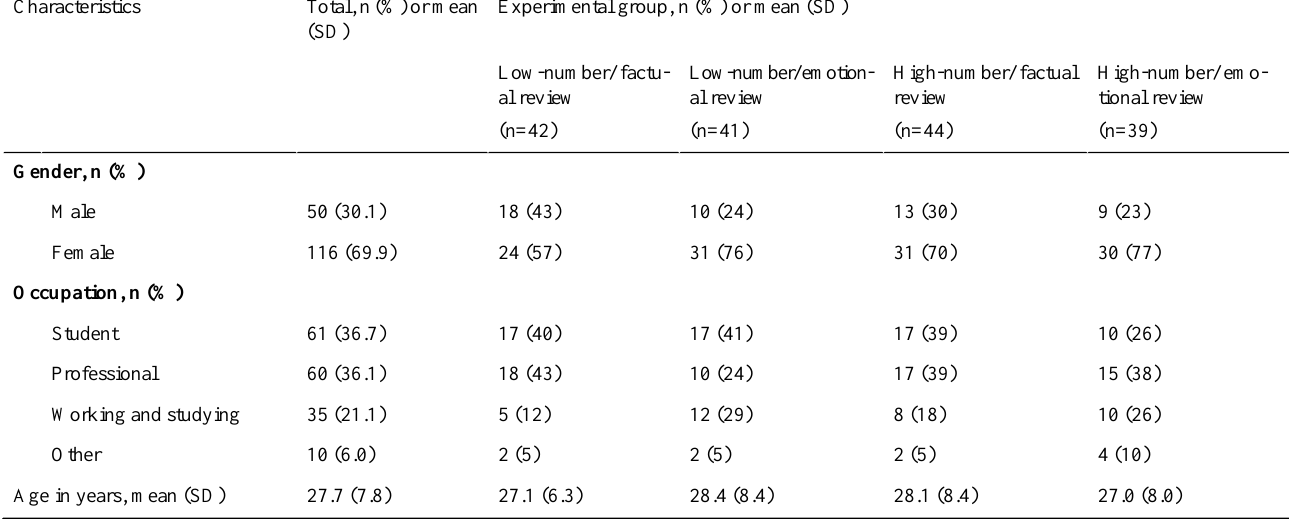
Table 1. Characteristics of the sample